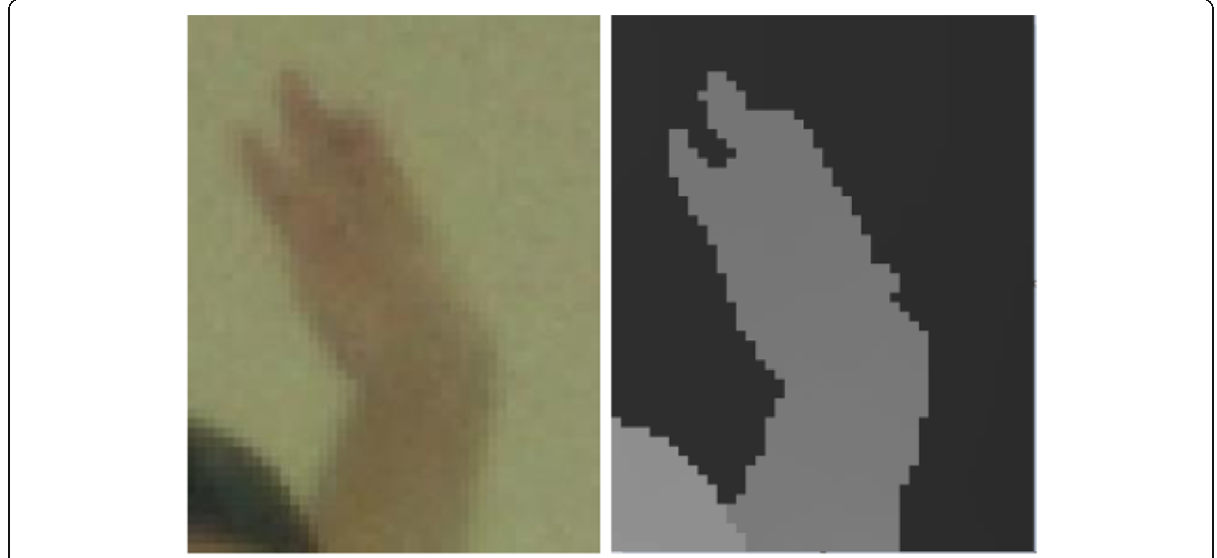
Fig. 2 The asymmetry in the transition area between foreground and background boundaries in color and depth